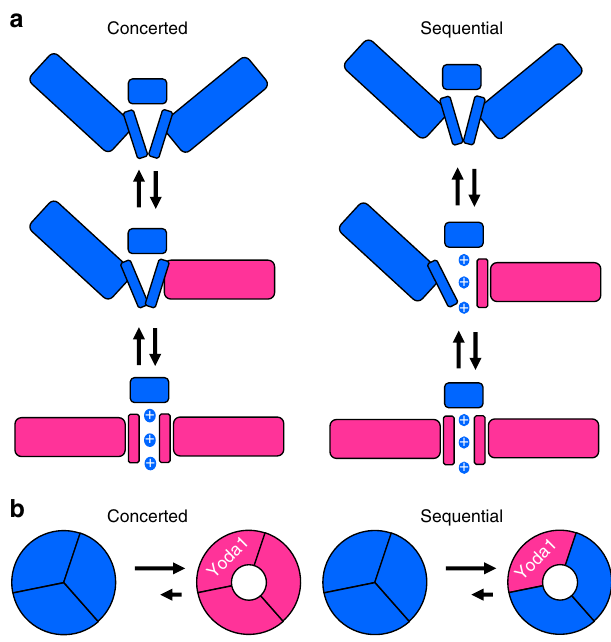
Fig. 9 Two possible gating mechanisms of Piezo1. Our study reveals Yoda1 sensitivity of Piezo1 requires the presence of only one Yoda1- sensitive subunit per trimer. This result is consistent with a concerted gating mechanism ( a ) where all subunits cooperatively gate the pore (blue: resting subunits; magenta: activated subunits). This result is also consistent with a sequential mechanism ( b ) where the pore fully opens if only